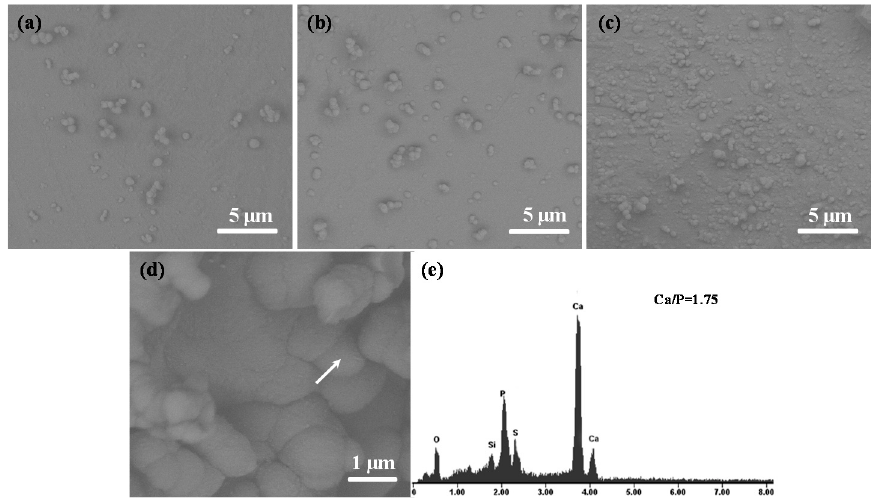
Figure 9. Morphology of the scaffolds with 5 wt % ZnOw after soaking in simulated body fluid (SBF) for ( a ) one day; ( b ) three days and ( c , d ) five days; ( e ) energy dispersive spectroscopy (EDS) analysis of precipitates on the scaffolds. The arrow indicates the precipitates for EDS analysis.